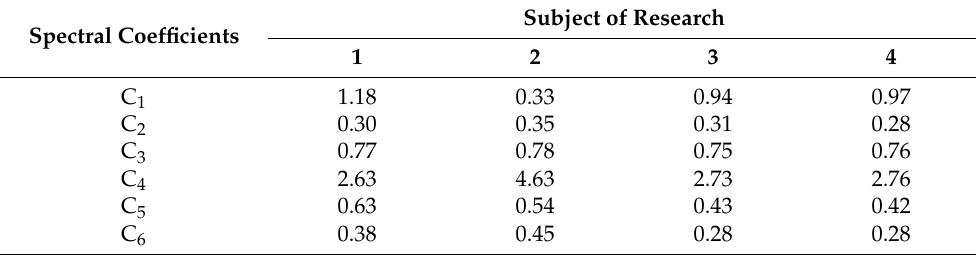
Table 6. Results of IR spectral analysis of